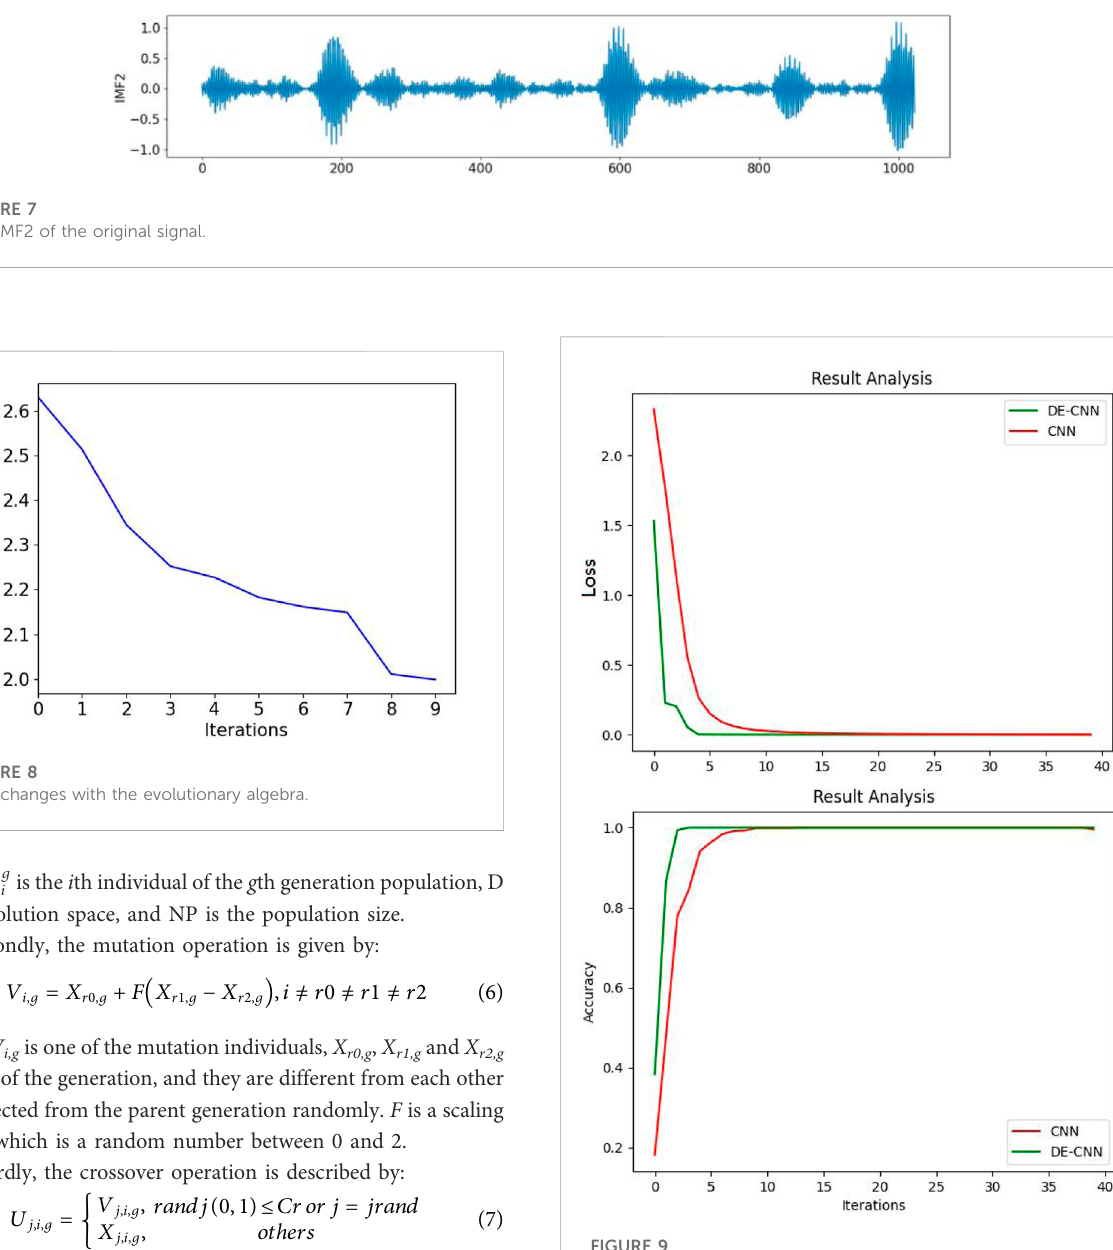
FIGURE 9 The comparison of loss and accuracy between the CNN and the DE-CNN.